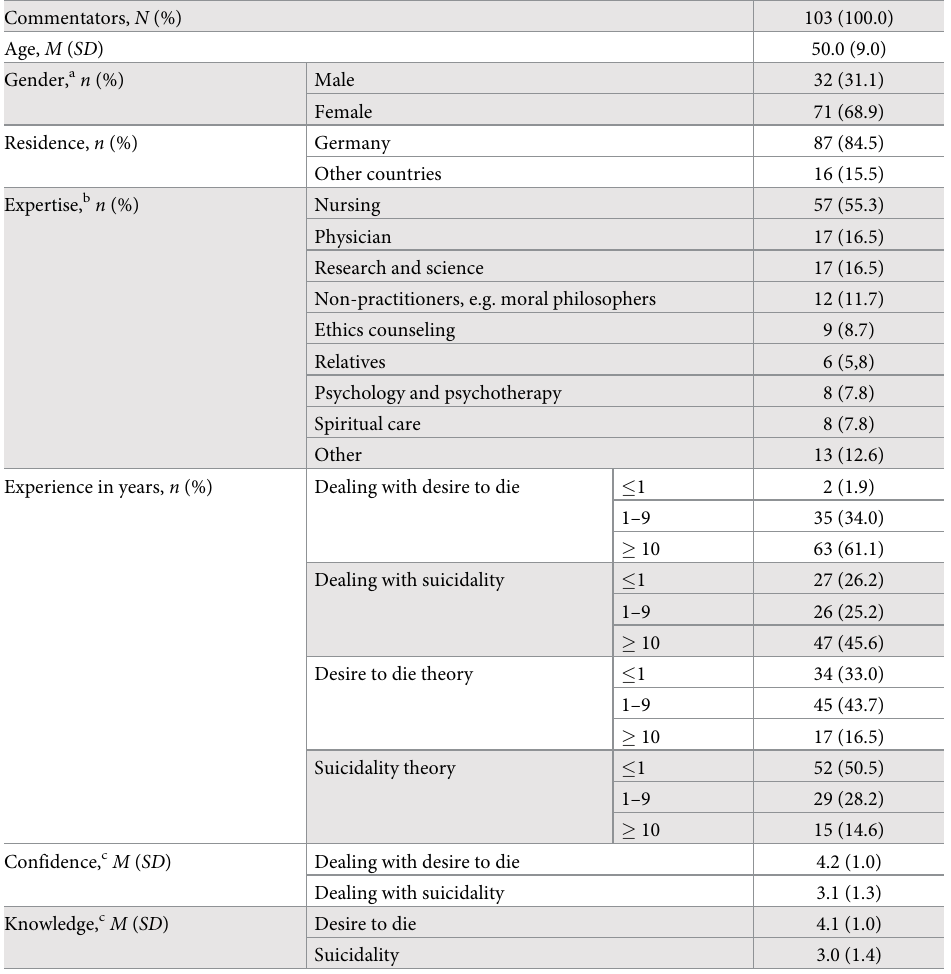
Table 2. Sociodemographic data of